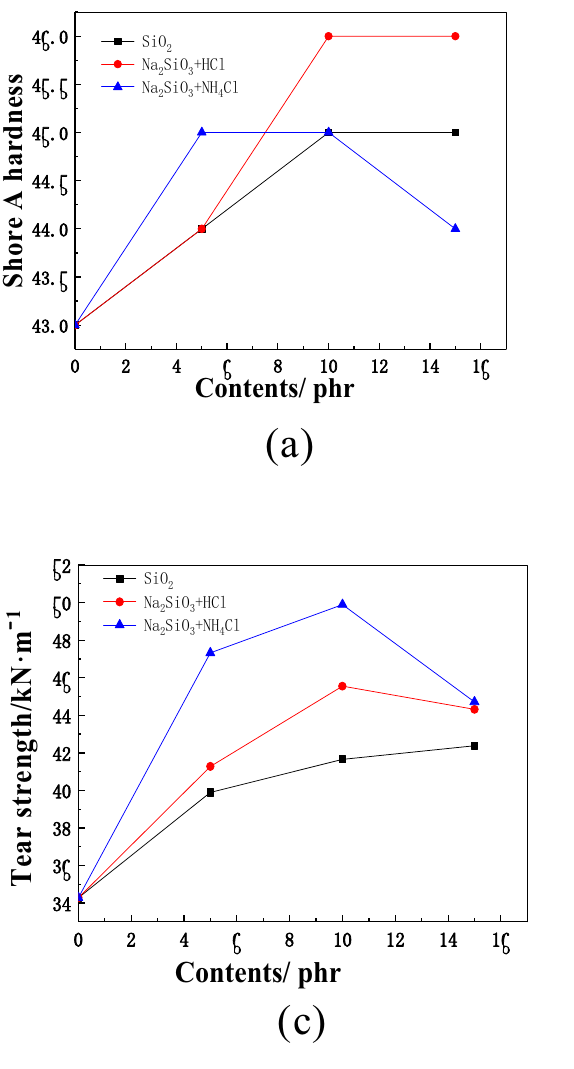
Figure 2: The mechanical properties amount of silica for NR/silica composites with di ff erent processes: ( a ) shore A hardness, ( b ) percentage of breaking elongation, ( c ) tear strength, and ( d ) tensile